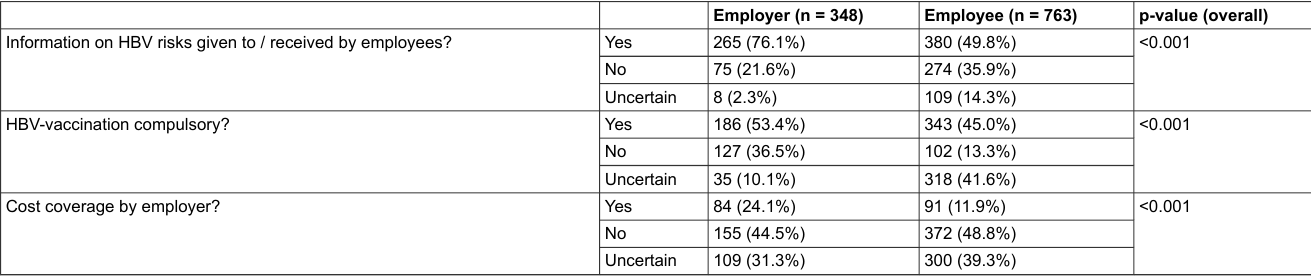
Employer (n = 348) Employee (n = 763) p-value (overall)